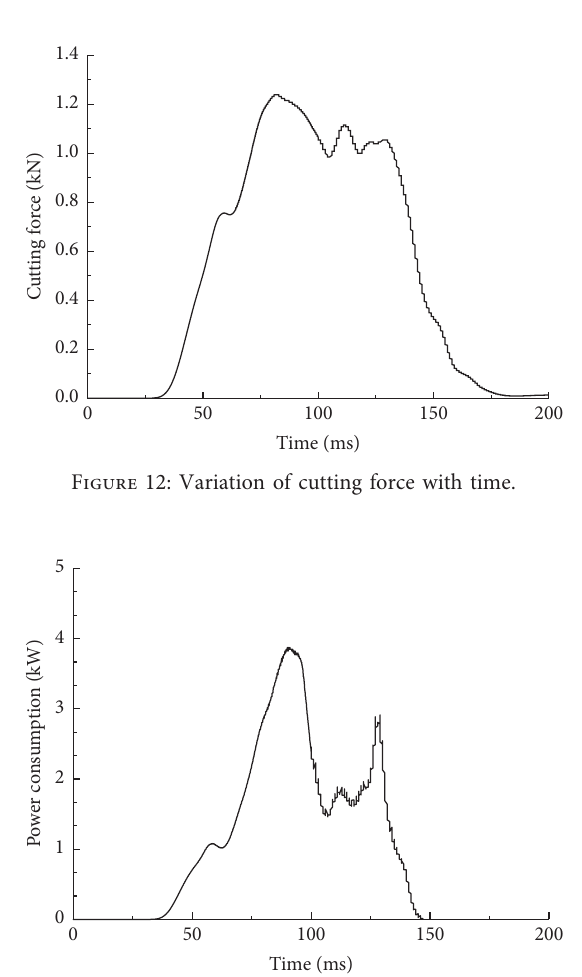
Figure 13: Variation of power consumption with